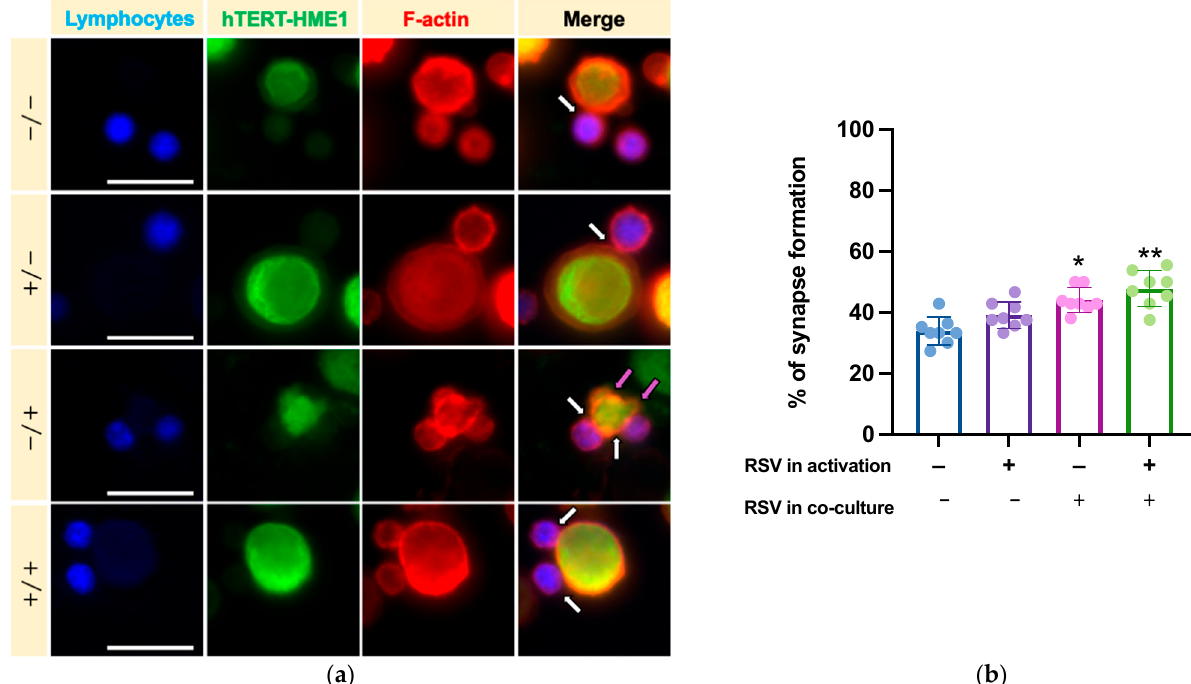
Figure 5. Effects of RSV on immune synapse formation. ( a ) To track the synapse formation, lymphocytes (effector cells) were pre-stained with ViaFluor (blue), hTERT-HME1 (target cells) with CFSE (green), while F-actin was evidenced with rhodamine phalloidin (red). White arrows highlight the interactions between effector and target cells, while magenta arrows indicate the blebbing of hTERT-HME1 due to cytotoxic activity. ( b ) Histograms represent the mean values and standard deviations of the percentage of synapse formation in the four different conditions. − / − = no RSV in the activation and killing phases; + / − = RSV in the activation phase only; − / + = RSV in the killing phase only; + / + = RSV in the activation and killing phases. Images are representative of fields from 8 independent experiments. Original magnification: 40×; scale bar = 20 µm. ( b ) Percentage of immune synapses in the different experimental conditions. Data are expressed as mean ± SD. * p < 0.05 vs. NA; ** p < 0.01 vs. NA.